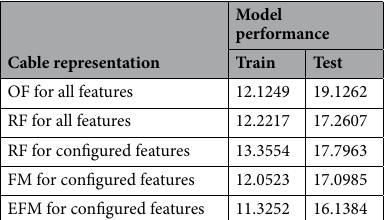
Table 1. Model performance of different cable